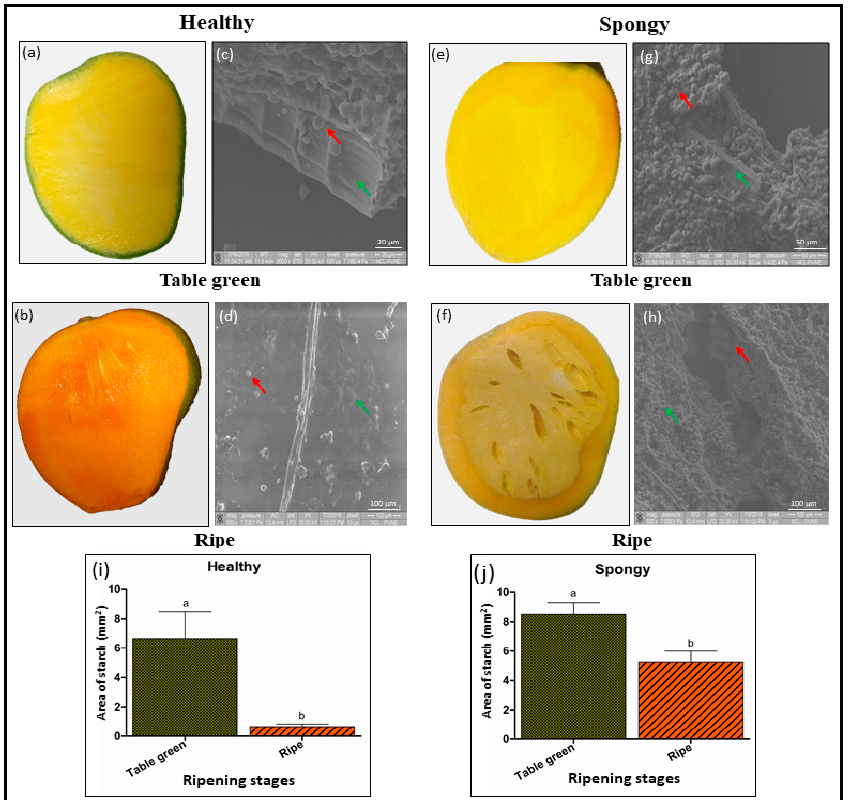
Figure 1. Cellular morphology of healthy and spongy mesocarp of mango fruit at table green and ripe stages. ( a ) and ( b ) represent the healthy mesocarp while and ( e ) and ( f ) represent spongy mesocarp at the above two stages. Representative scanning electron microscopic images of healthy ( c and d ) and spongy ( g and h ) mesocarp at two ripening stages are included adjacent to the respective fruit images. Red arrow indicates starch granules whereas green arrow indicates parenchyma cells. ( i ) and ( j ) histograms represent average area in mm 2 covered with starch granules calculated from five different regions each of two respective SEM images of both the healthy and the spongy tissue, respectively at two stages. Normalization was done based on the scale represented on each image. Difference between ripening stage across tissue was significant ( p ≤ 0.05) if lower case letters (a, b) above histogram are different.